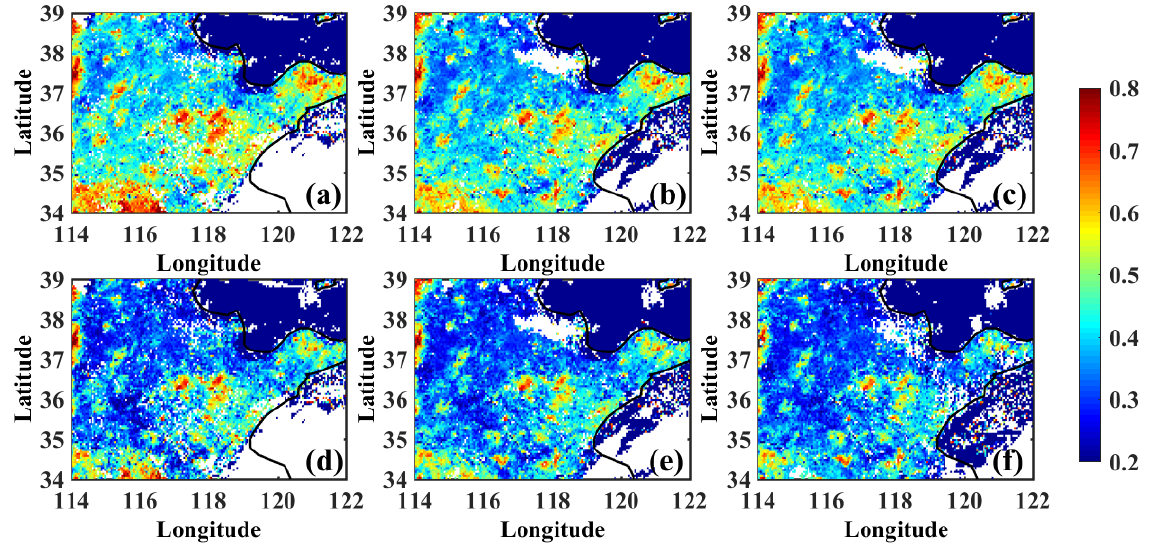
Figure 10. NDVI derived from AHI ( a ) 00:00 UTC, ( b ) 02:00UTC and ( c ) 04:00 UTC before angle correction. ( d – f ) are corresponding NDVI after AHI angle correction.